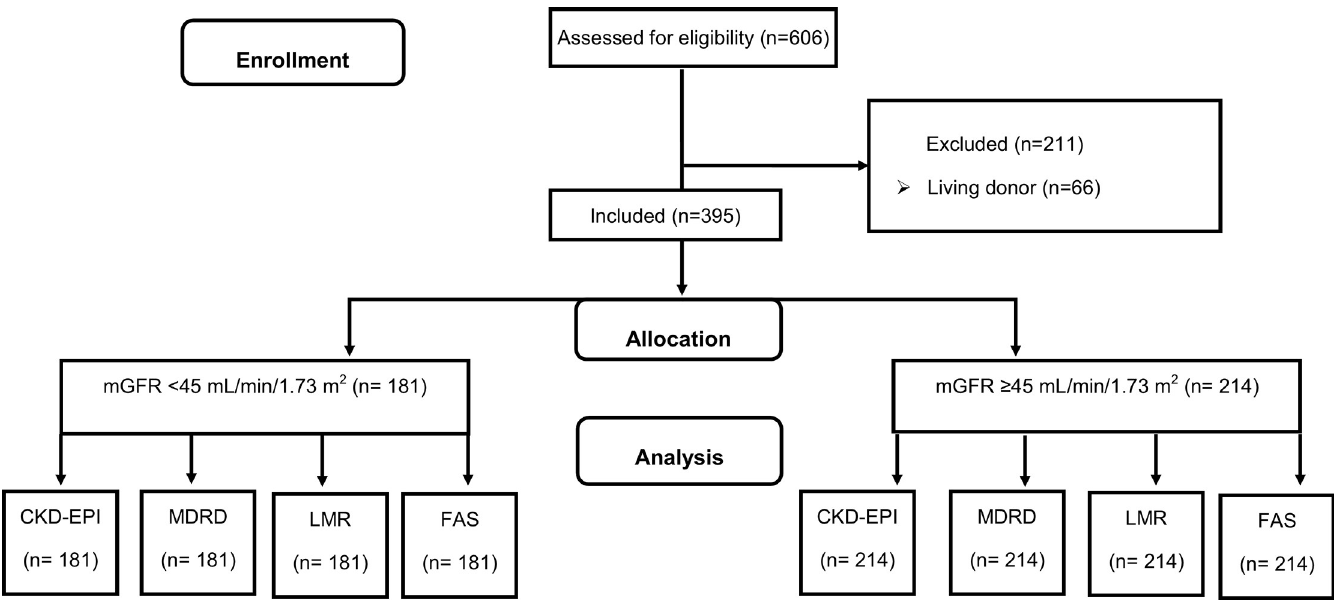
Fig 1. Flow chart of the study. GFR, glomerular filtration rate; CKD-EPI, chronic kidney disease epidemiology collaboration equation; MDRD, Modification of Diet in Renal Disease Study; LMR, Lund-Malmo¨ revised equation; FAS: full age spectrum